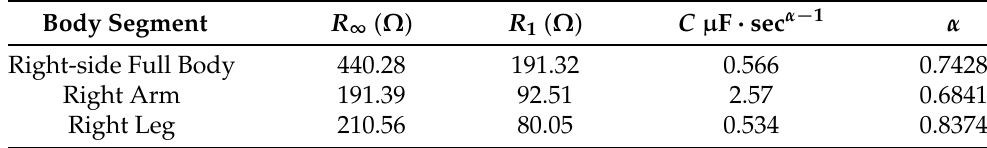
Table 1. Median Cole-impedance model parameters ( R ∞ , R 1 , C , α ) identified by the PSO to best-fit the 174 participant right-side full body, right arm, and right leg bioimpedance